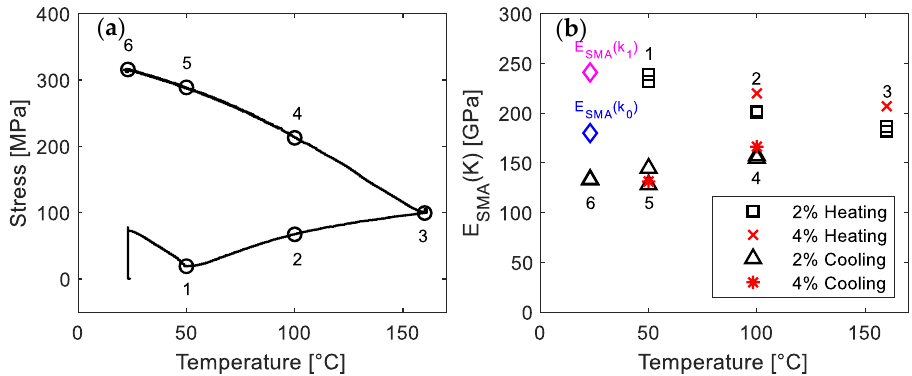
Figure 10. Evolution of E SMA ( κ ) in activation. ( a ) Number 1–6 show the interrupted temperatures during activation. ( b ) The corresponding E SMA ( κ ). Figure 11a comprises the σ vs. ε ( σ = σ − σ 0 ; ε = ε − ε 0 ) at the beginning of loading Table 3. The values of σ 0 , E SMA ( κ ), and R 2 at all experimental temperatures in activation. Pre-Straining